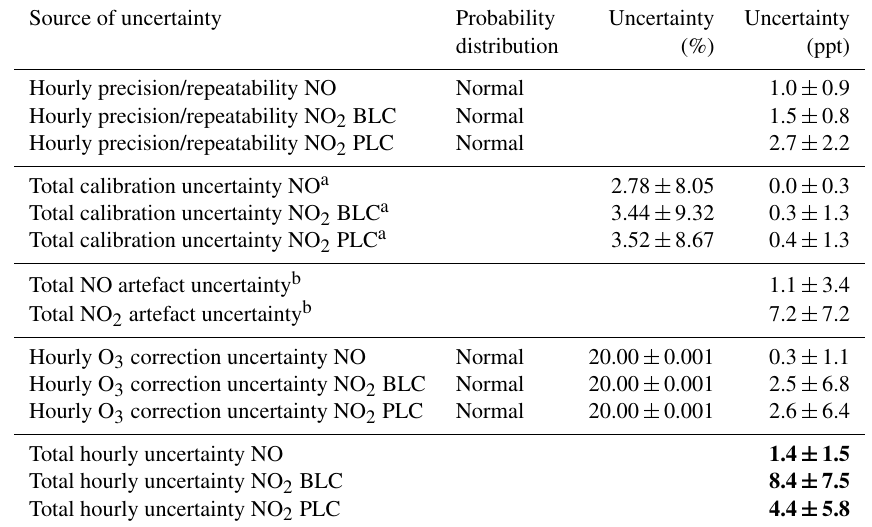
Table 2. Calculated uncertainties associated with the NO x measurements. The values in bold are the combined uncertainties for each type of measurement. Each uncertainty is given as the mean uncertainty ± 2 standard deviations of the data between January 2014 and August 2019 for NO and from March 2017 to August 2019 for both NO 2 measurements.